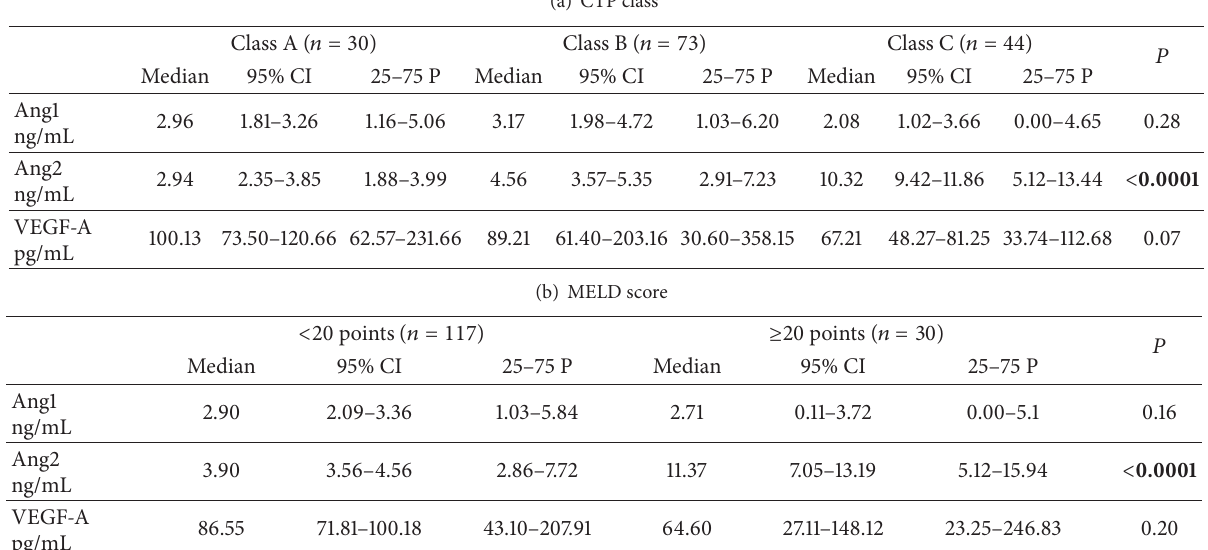
Table 4: Plasma angiogenesis-related biomarkers in subgroups of patients with different grades of liver